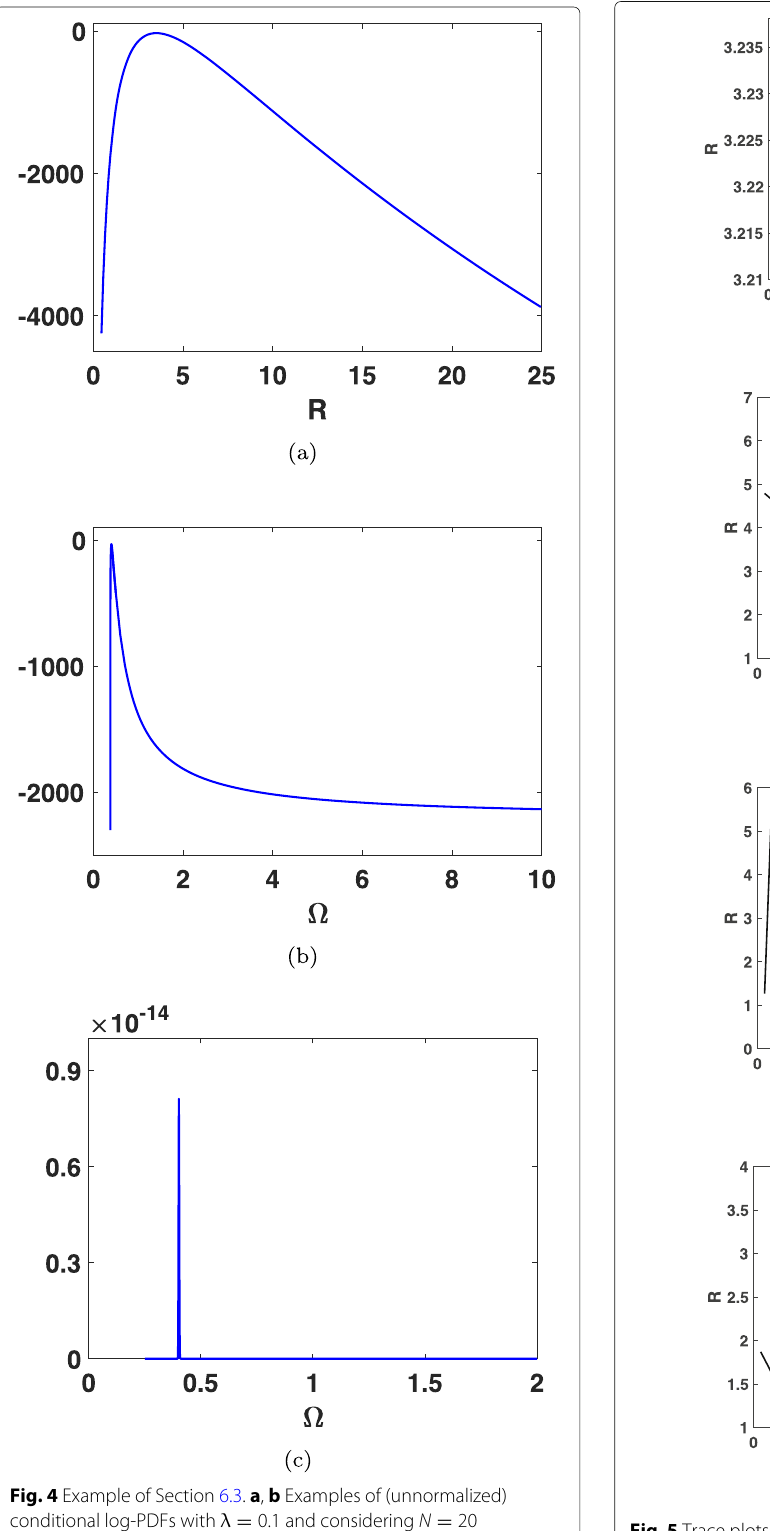
Fig. 5 Trace plots for R in the example of Section 6.3. a FUSS-within-Gibbs. b – d MH-within-Gibbs for σ = 0.2 ( b ), σ = 1 ( c ) and σ =